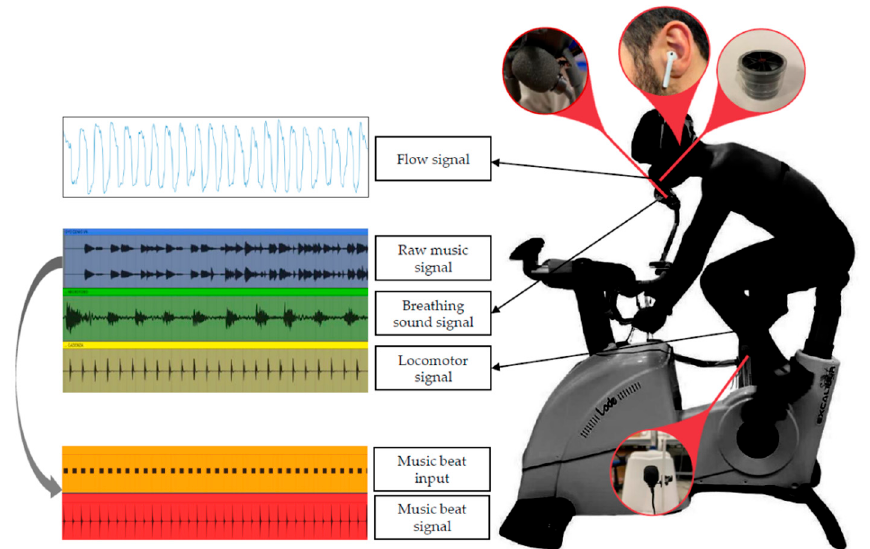
Figure 4. Graphical description of the sensors used in this study and the related signals. Note that, after data acquisition, the raw music signal was visually inspected by an experienced musician for the identification of each music beat (music beat input), and then converted into the music beat signal for further analysis.